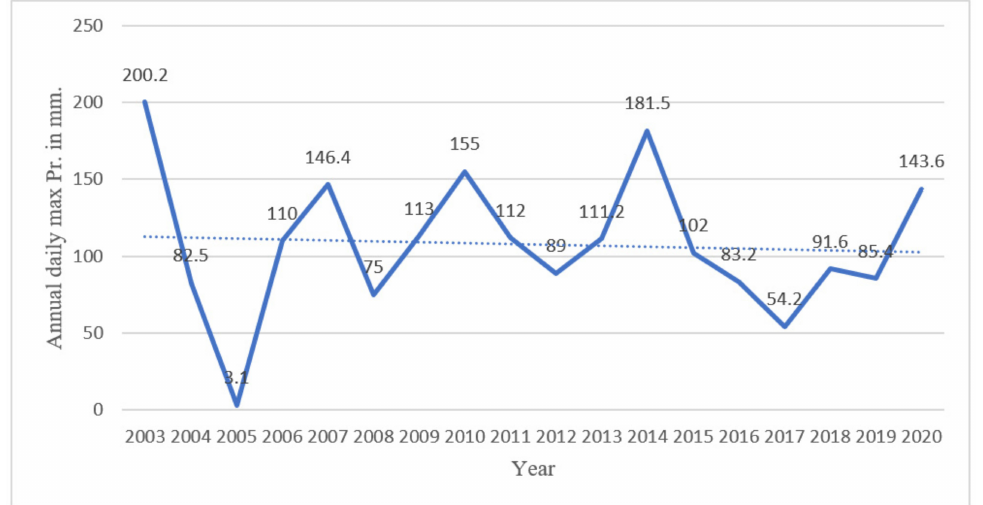
Figure A5. Observed annual daily maximum precipitation of Bandipur,